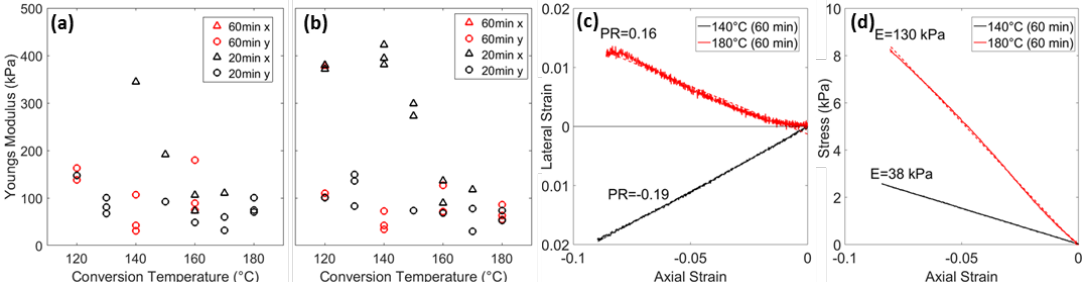
Figure 4. ( a ) Compressive and ( b ) Tensile modulus (identical y-axis, key showing conversion times & sample axial direction; ( c ) Lateral true strain vs. axial true strain and ( d ) Stress vs. axial true strain for two ‘comparative’